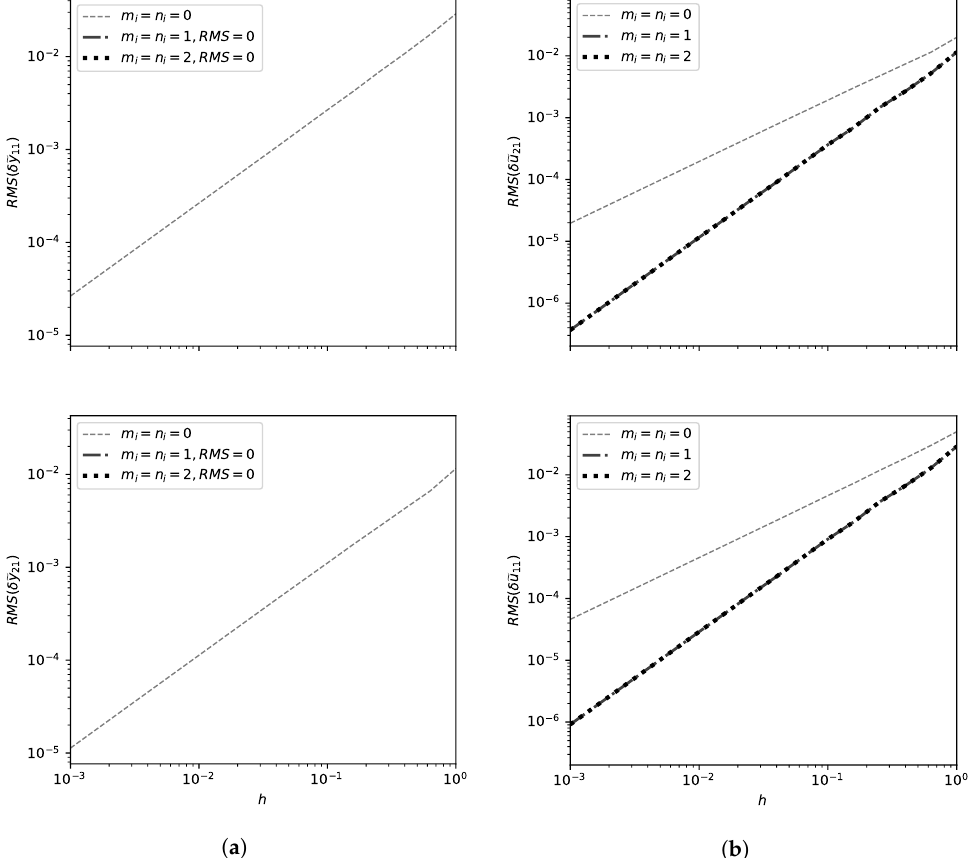
Figure 5. The diagrams show the defects of the fixed-step Jacobi co-simulation method (Algorithm 1, H [ k ] = H [ k − 1 ] = H 1 ) and different orders of interpolation polynomials m i = n i : ( a ) Output defects; ( b ) Connection